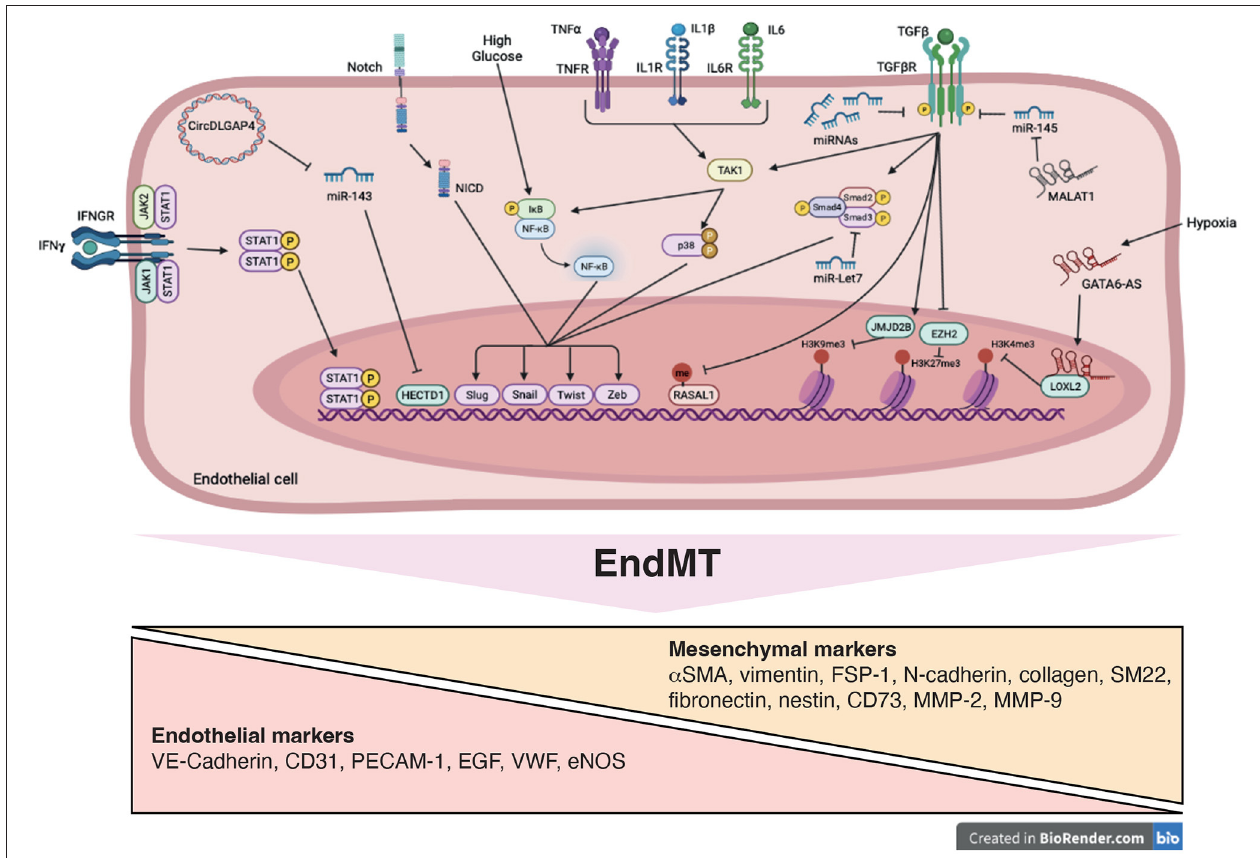
FIGURE 3 | Signaling pathways and mechanistic drivers of endothelial-to-mesenchymal transition (EndMT). Stimulation with transforming growth factor- β (TGF β ), cytokines, Notch ligands, high glucose and hypoxia induce expression of transcription factors, such as Twist, Slug, Zeb and Snail resulting in EndMT. Epigenetic mechanisms including modifications of histone methylation marks and methylation of CpG island are induced. These processes are mediated by variety of actors such as microRNAs (miRNAs), long non-coding RNA (GATA6-AS and MALAT1), circularRNA (DLGAP4) and signaling pathways including SMAD, STAT, NF κ B, and p38, promoting